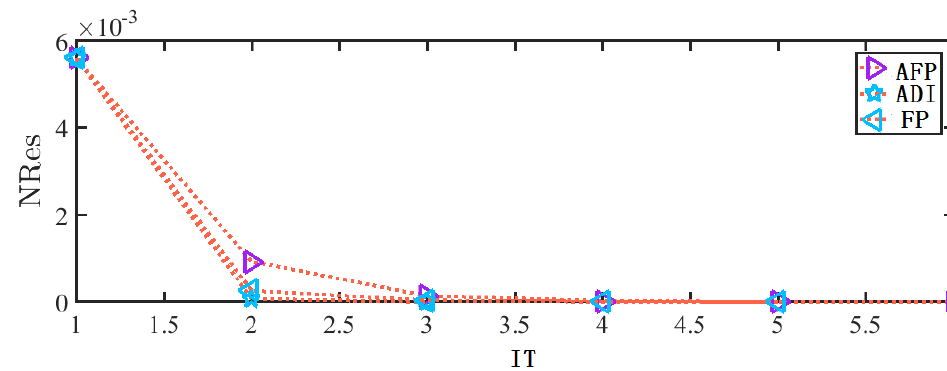
Figure 5. The relation of IT and NRes for the three algorithms when P 0 = ˆ P 1 .